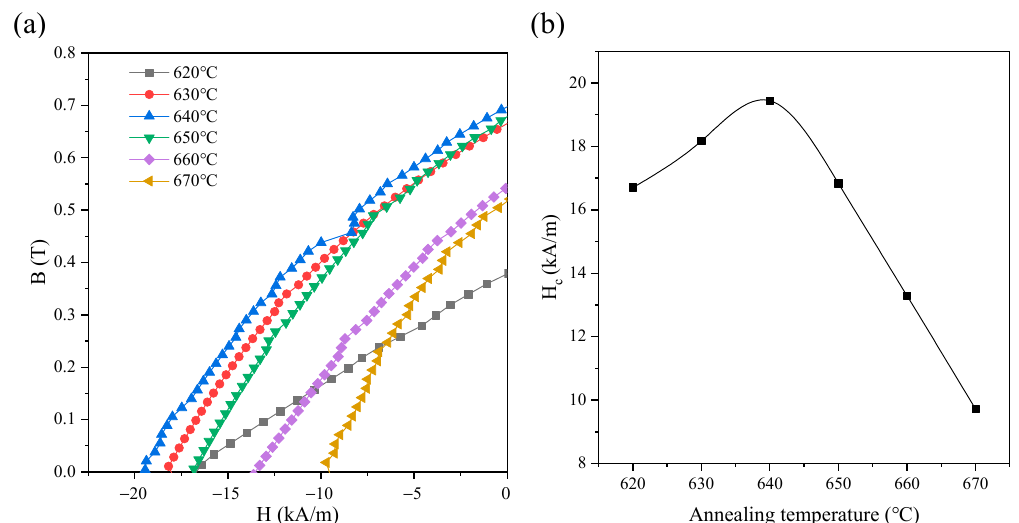
Figure 5. ( a ) Demagnetization curves of Fe-25Cr-15Co samples treated at different annealing tem- peratures and ( b ) the corresponding H c .